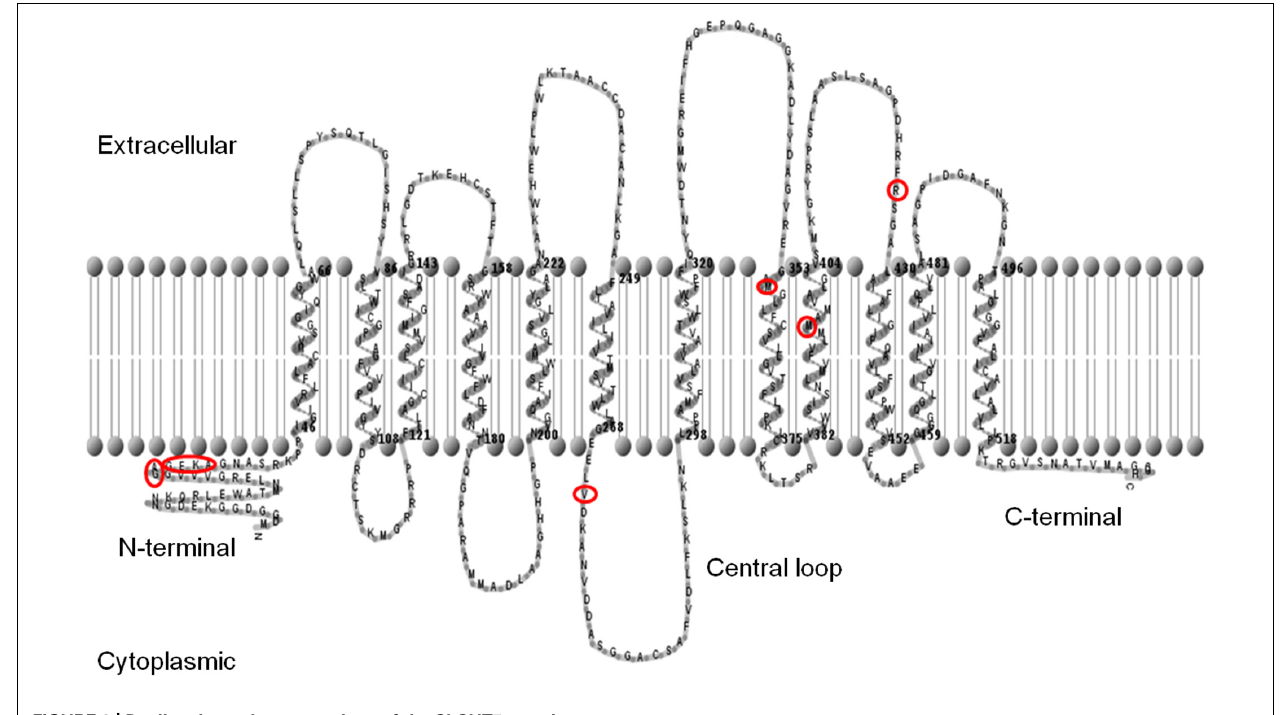
domains are predicted.The membrane topology was generated using theTMHMM server v 2.0 (http://www.cbs.dtu.dk/services/